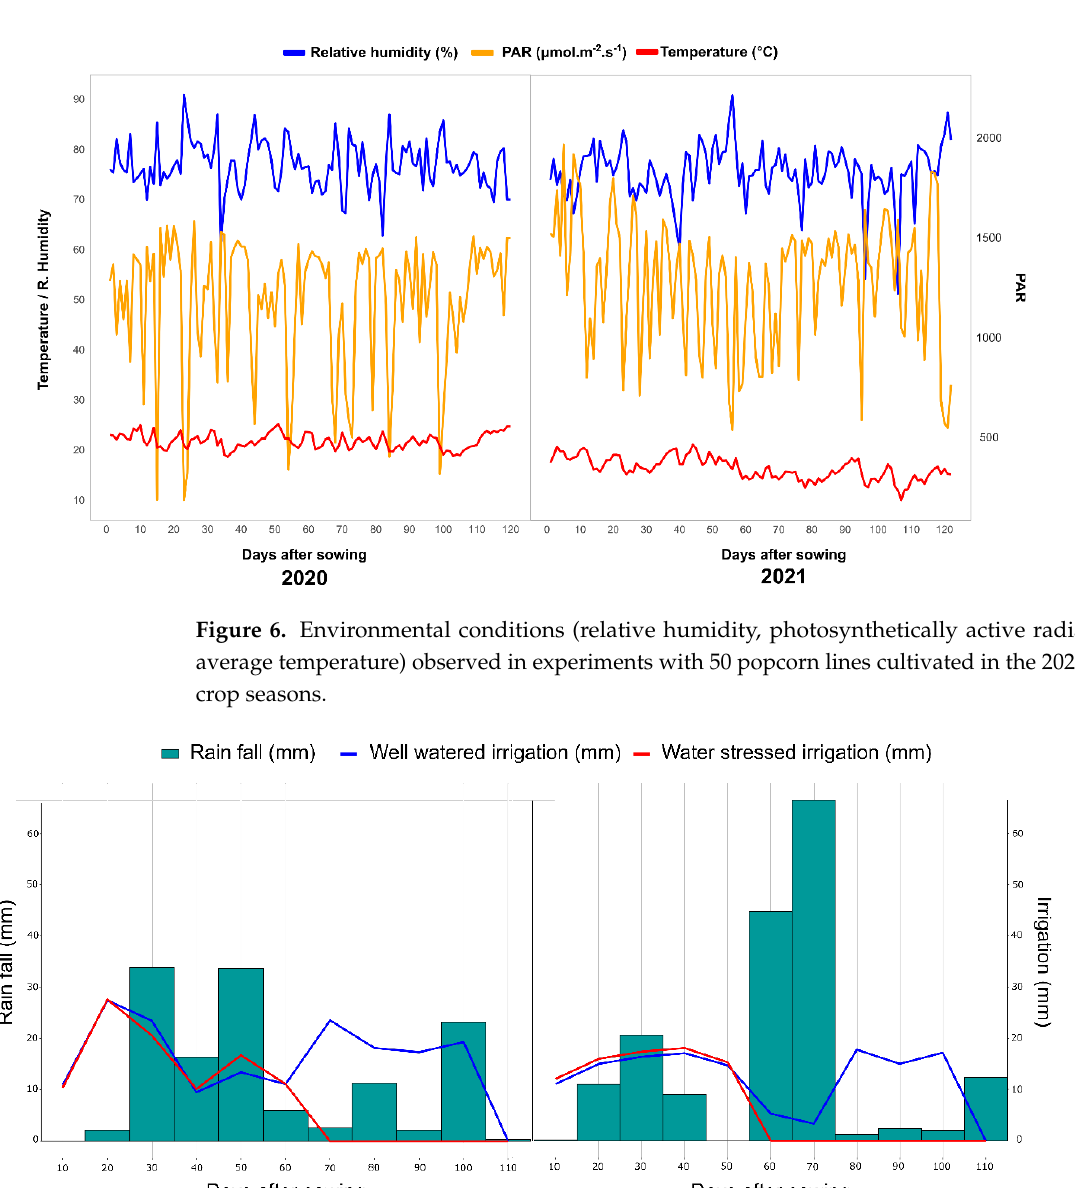
Figure 6. Environmental conditions (relative humidity, photosynthetically active radiation, and av- erage temperature) observed in experiments with 50 popcorn lines cultivated in the 2020 and 2021 crop seasons.